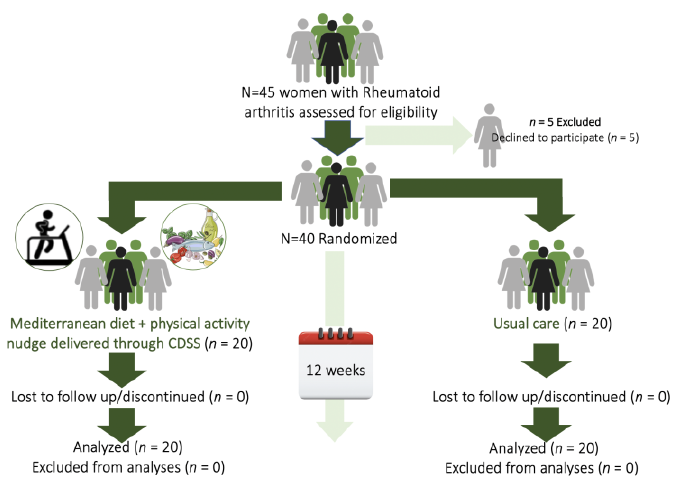
Figure 1. CONSORT [32] diagram of the study’s procedures.